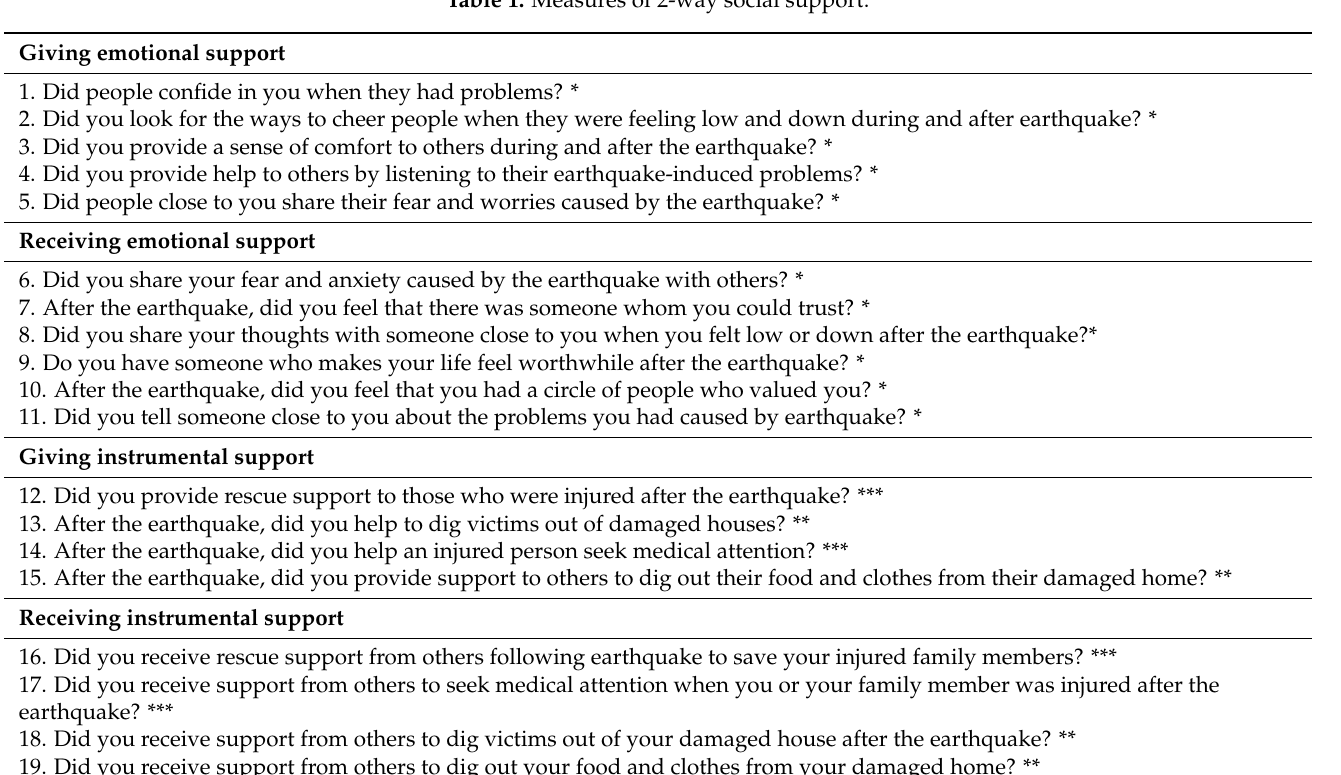
Table 1. Measures of 2-way social